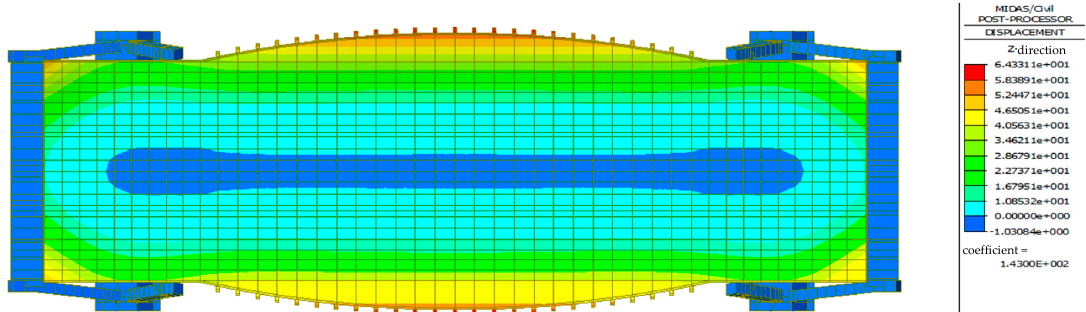
Figure 22. Deformation of the box girder after installation of the bottom plate (unit: mm).